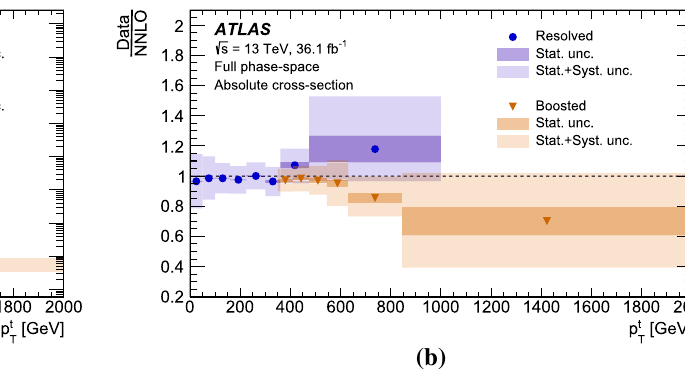
Fig. 69 a Comparison between the measured full phase-space nor- malised differential cross-sections in the resolved and boosted topolo- gies as a function of the transverse momentum of the top quark. b The ratios of the measured full phase-space absolute differential cross-